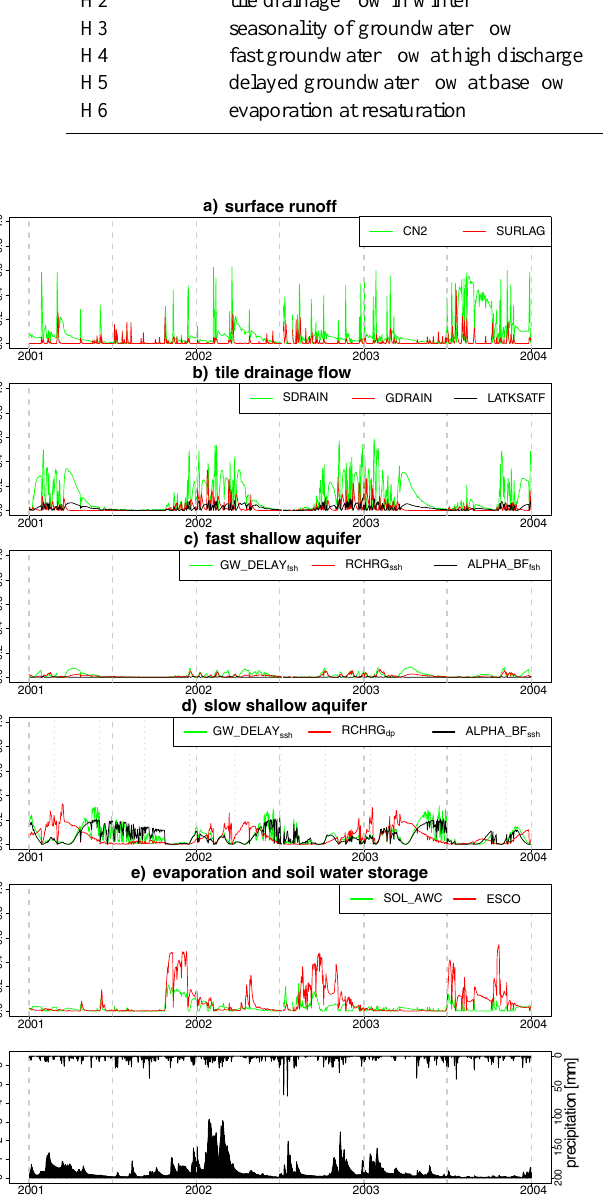
Figure 3. Temporal parameter sensitivities for all analysed model parameters from 2001 to 2004. Based on the processes they con- trol, the parameters are grouped into surface runoff (a) , tile drainage flow (b) , process dynamics of the fast shallow aquifer (c) and the slow shallow aquifer (d) , evaporation, and soil water storage (e) . The bottom plot shows the observed discharge and